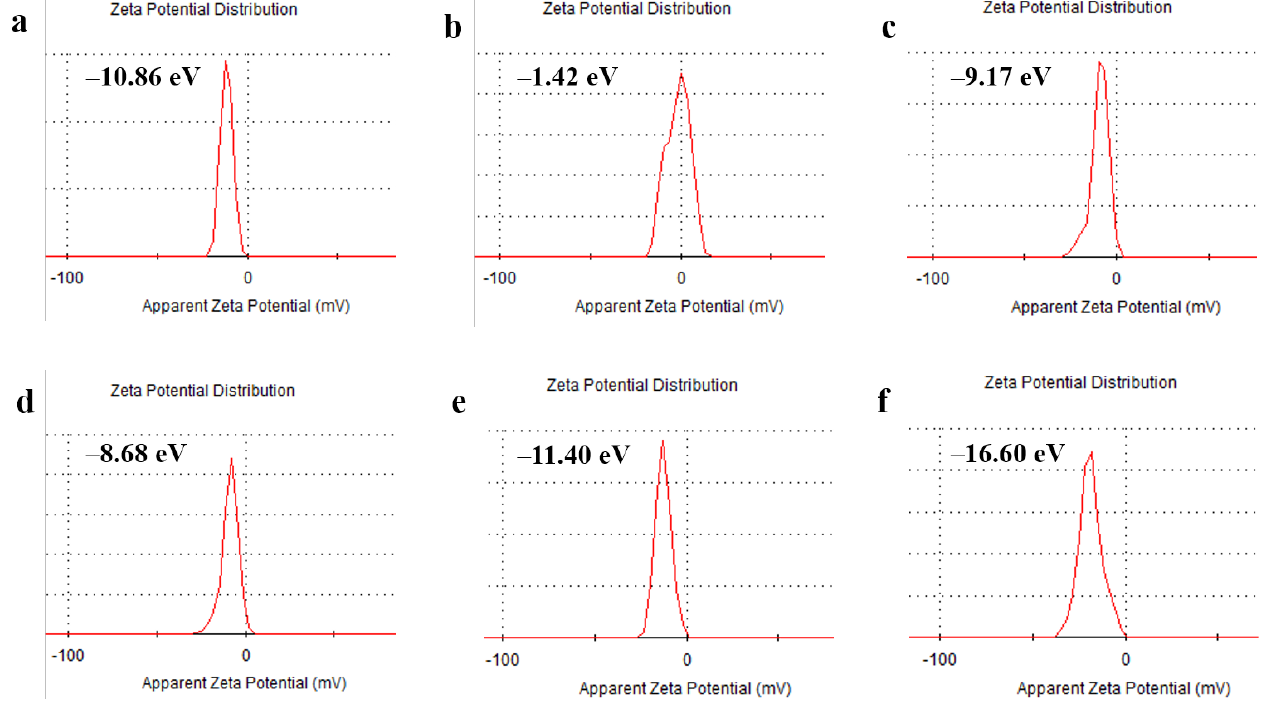
Figure 4. Zeta potentials of ( a ) MPDA, ( b ) MPDA-Fe(III)-DOX, ( c ) MPDA-Fe(III)-DOX-HA, ( d ) m(MPDA-Fe(III)-DOX):m(HA) = 1:1, ( e ) m(MPDA-Fe(III)-DOX):m(HA) = 1:2, ( f ) m(MPDA-Fe(III)-DOX): m(HA) = 1:3.